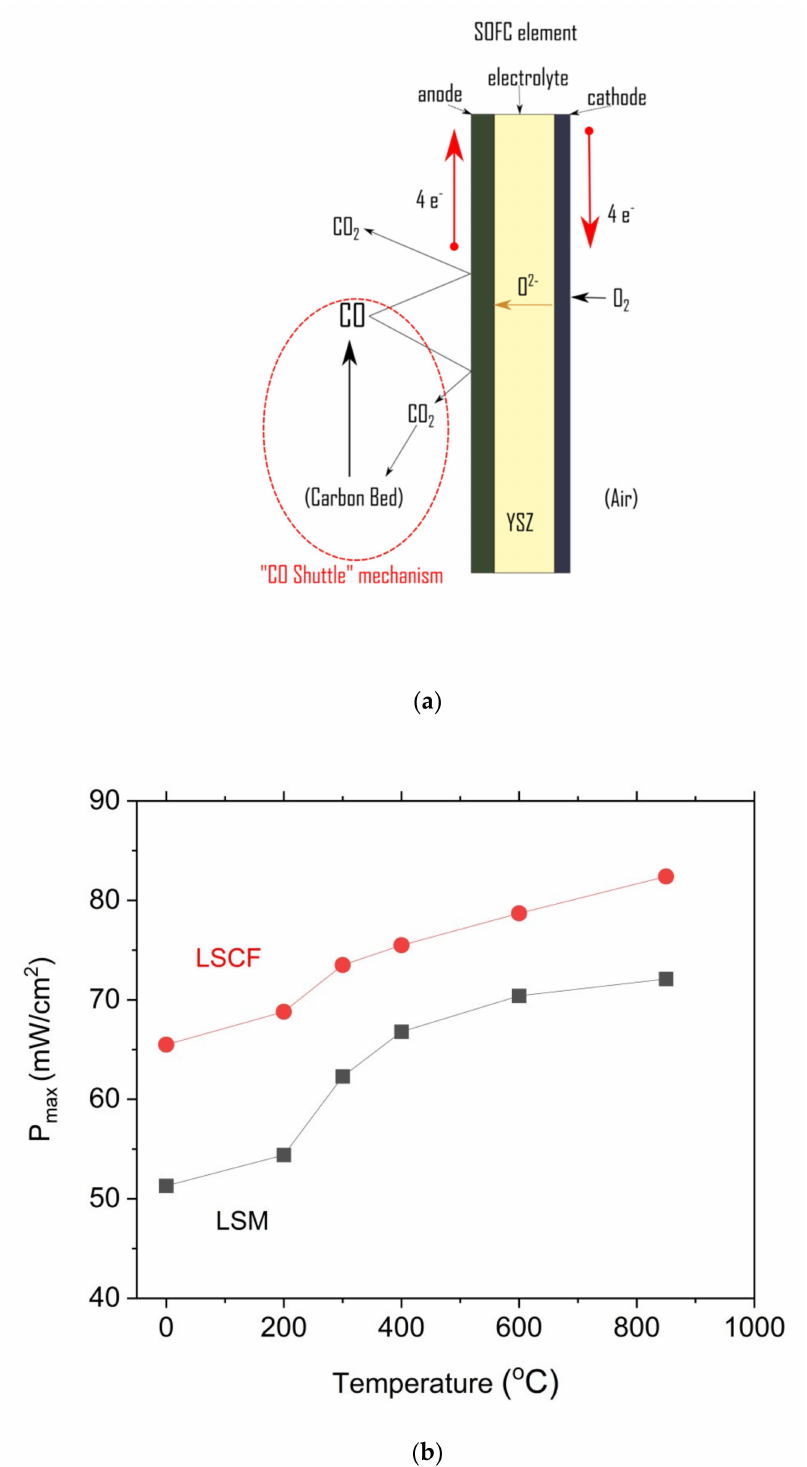
Figure 17. ( a ) Idea of electrochemical oxidation of carbon particles in DS-SOFCs according to CO shuttle mechanism [65]. ( b ) Dependence of P max vs. the temperature of solid fuels preparations. Data were determined for DC-SOFC (I) with an LSM cathode or DC-SOFC (II) with a LSCF cathode and operated at 850 ◦ C. CO 2 gas atmosphere over